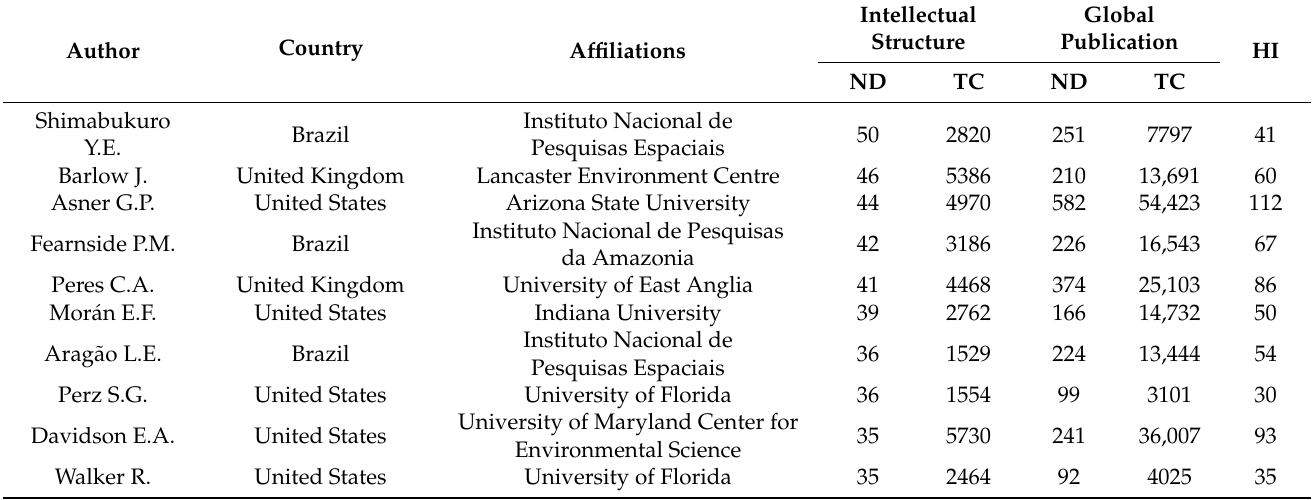
Table 3. Top 10 leading authors by their number of publications and number of